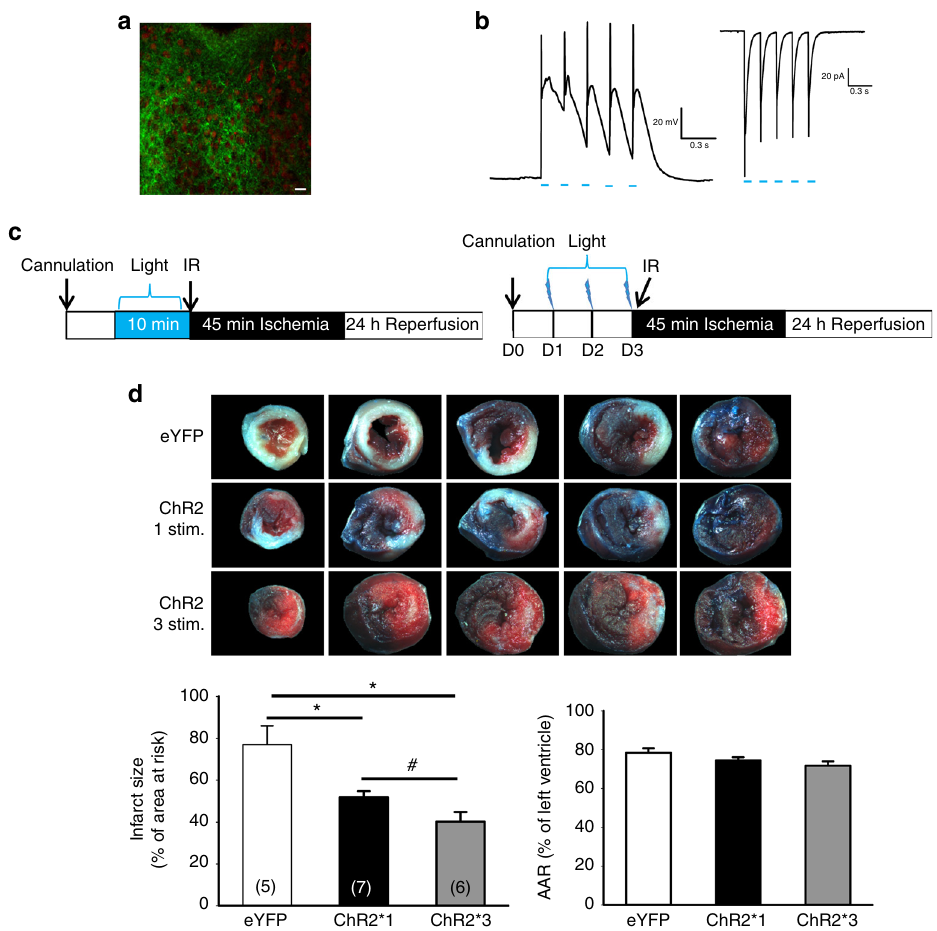
Fig. 6 Optogenetic activation of PVA neurons induces cardioprotection. a Immuno fl uorescent images of hChR2(H134R)-EYFP-positive signals in PVA regions, brain section was co-stained with neuronal marker, NeuN (red signal) ( scale bar = 20 μ m). b Representative action potential recording of hChR2 (H134R)-EYFP-positive neurons in PVA elicited by blue light stimulation (5 mW mm − 2 , 5 Hz, 10 ms pulse indicated by blue lines ) ( left panel ). Inward currents elicited by blue light stimulation from hChR2(H134R)-EYFP-positive neurons ( right panel ). c Schematic of experimental design showing the timeline for single and repeated blue light stimulation and myocardial IR surgery. d Representative images of TTC staining in heart cross-sections. Quanti fi cation results of infarct size and AAR in cardiac sections from EYFP and ChR2 one stimulation (ChR2 1 stim.) and ChR2 three stimulations (ChR2 3 stim.) groups. Optogenetic stimulation of neurons in PVA for 10 min or 3 consecutive days prior to IR surgery protected heart from IR injury. * p < 0.05 vs. eYFP group. # p = 0.05. Error bars indicate SEM. Statistical signi fi cance was determined by one-way ANOVA ( d